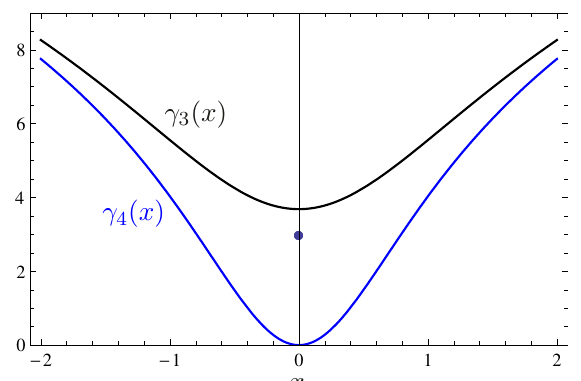
Figure 1 . Anomalous dimensions γ 3 ( x ) (3.11) and γ 4 ( x ) (3.18) of higher-twist DAs. The anomalous dimension of the special (discrete) twist-three state γ (0)